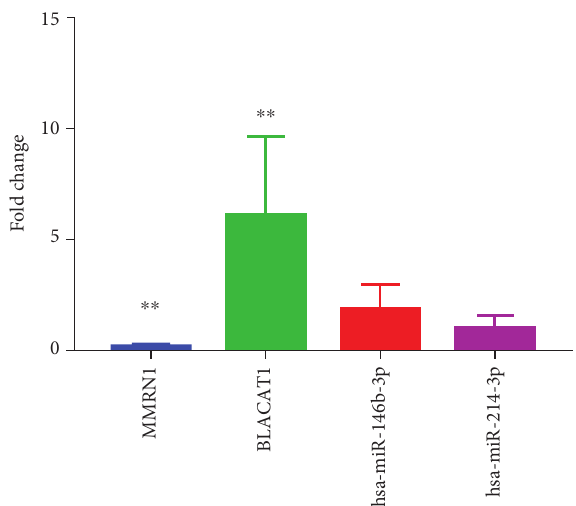
Figure 9: The ex vivo validation of BLACAT1, hsa-miR-146b-3p, hsa-miR-214-3p, and MMRN1 in 7 PTC patients. Fold change > 1 and fold change < 1 represent upregulation and downregulation, respectively. ∗∗ p < 0 . 01.